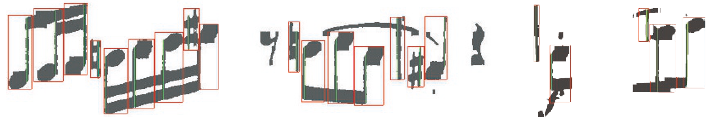
Figure 9: Segmentation of symbols featured by a vertical segment.